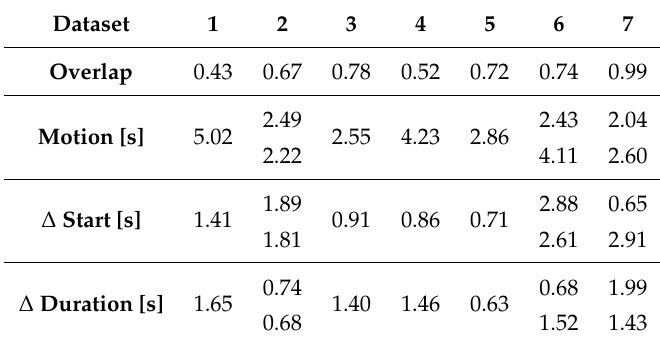
Table 2. Recognition performance of template matching for picking dataset. The overlap (avg. 69%) is excluding outliers and represents only the best match within a dataset. Cases 2, 6, and 7 contain two grabbing activities.